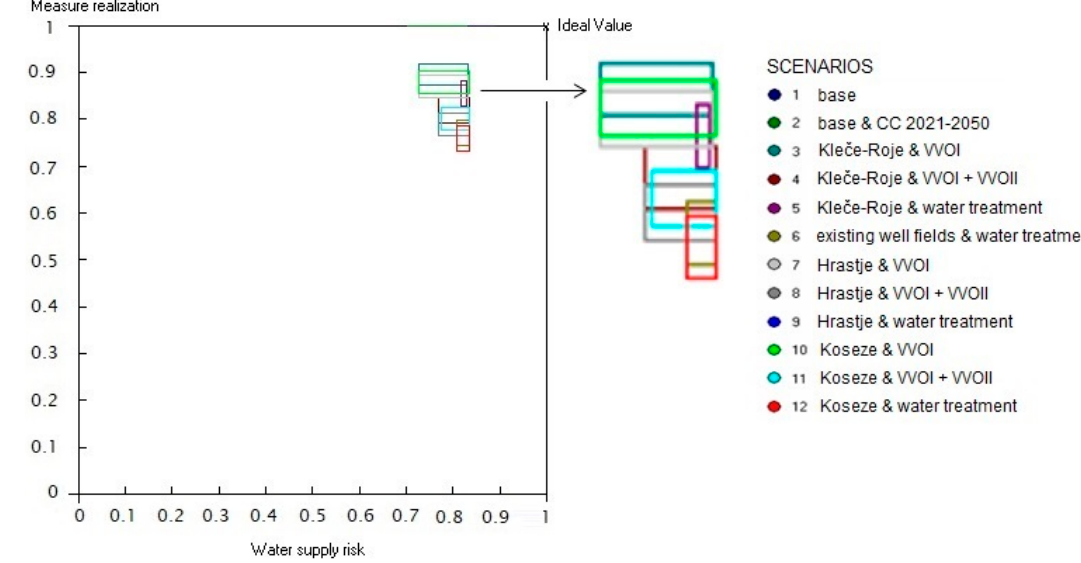
Figure 5. Ranking of the management actions according to the ranking criteria for the Ljubljana Field aquifer (case 4: measure realization parameter flexibility is set to 1 (management actions with VVOI), 3 (management actions with VVOII), and 5 (management actions with water treatment); weights for groundwater availability parameters (public water supply for households is set to 0.4, others to 0.2) and water contamination risk parameters (costs 0.5, lag time 0.3, flexibility 0.2).